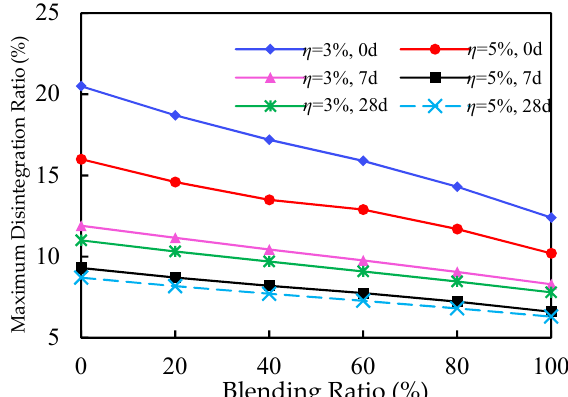
Figure 8. Relationship between D m and blending ratio of red clay with cement mixing ratios.